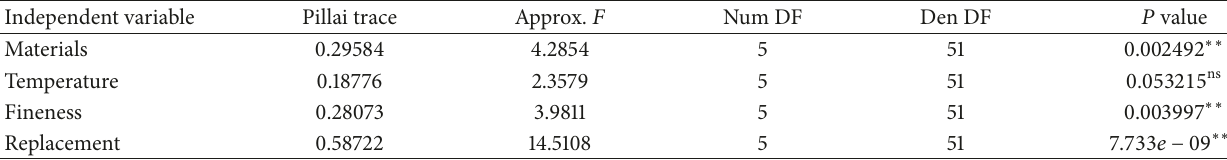
Figure 5: Influence of fineness on setting times: (a) scoria, (b) pumice, and (c) rice husk ash. Table 5: Factors influencing compressive strength